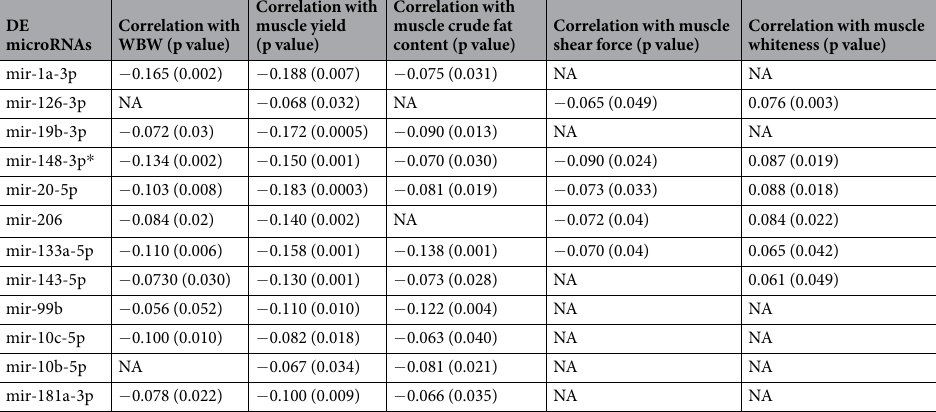
Muscle yield. There were a total of 18 microRNAs downregulated in the high muscle yield families compared to their low muscle yield counterparts (Fig. 2 and Supplementary Dataset 1C). Of them, expression pattern of 12 microRNAs including mir-1, mir-133 and mir-206 was validated by real time PCR, which showed consist- ency between qPCR and RNA-Seq approaches (Supplementary Dataset 1D). In addition, all 9 DE microRNAs that were chosen for phenotype-genotype regression analysis, negatively correlated with muscle yield (p < 0.05). Variation in expression level of each microRNA explained 6.8% to 18.8% of the variation in muscle yield, with the most significant microRNA being mir-1a-3p (Table 3). Although expression of mir-10c-5p and mir-181a-3p was not statistically different in the RNA-Seq data between high and low ranked muscle yield groups, their expression was significantly and negatively correlated with muscle yield based on qPCR quantification in random 90 indi- viduals (Table 3). To the best of our knowledge, 8 out of 18 DE microRNAs (mir-19d, mir-100–5p, mir-99a-5p, mir-148-3p, mir-199-5p, mir-148-3p * , mir-19b-3p and mir-140) were not reported before as associated with muscle growth. The remaining 10 DE microRNAs are known to directly or indirectly regulate skeletal muscle development in different species by regulating genes involved in myogenesis 12, 27 , muscle-growth-related signal transduction pathways 9, 28, 29 and cell cycle 30 . As an example, mir-1 and mir-133 are responsible for more than half